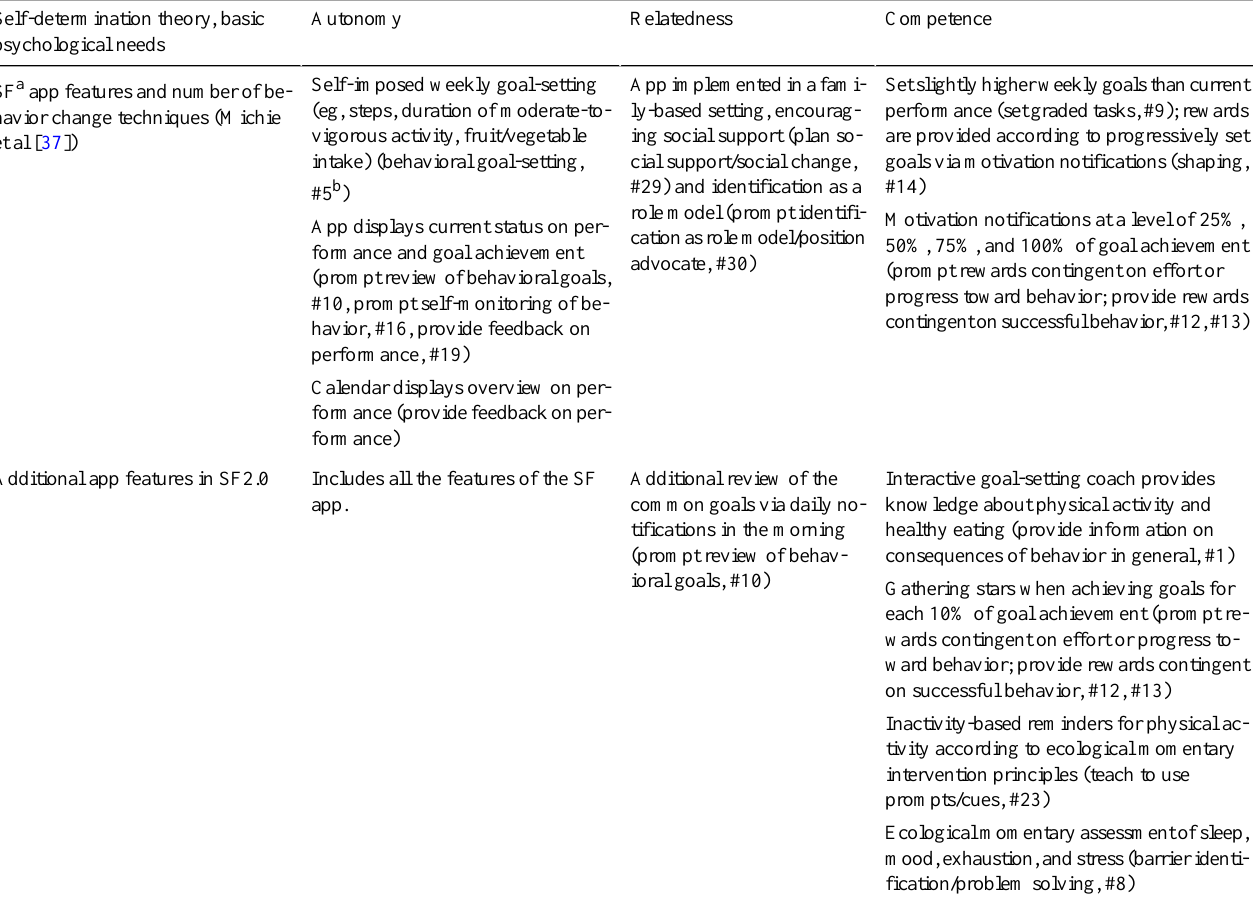
Table 1. Implementation of the basic psychological needs and behavior change techniques within the app features. CompetenceRelatednessAutonomySelf-determination theory,